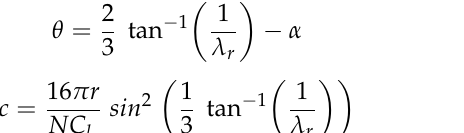
Figure 6. The changes of C P at various λ for the current research and the study of Anderson et al. [33].